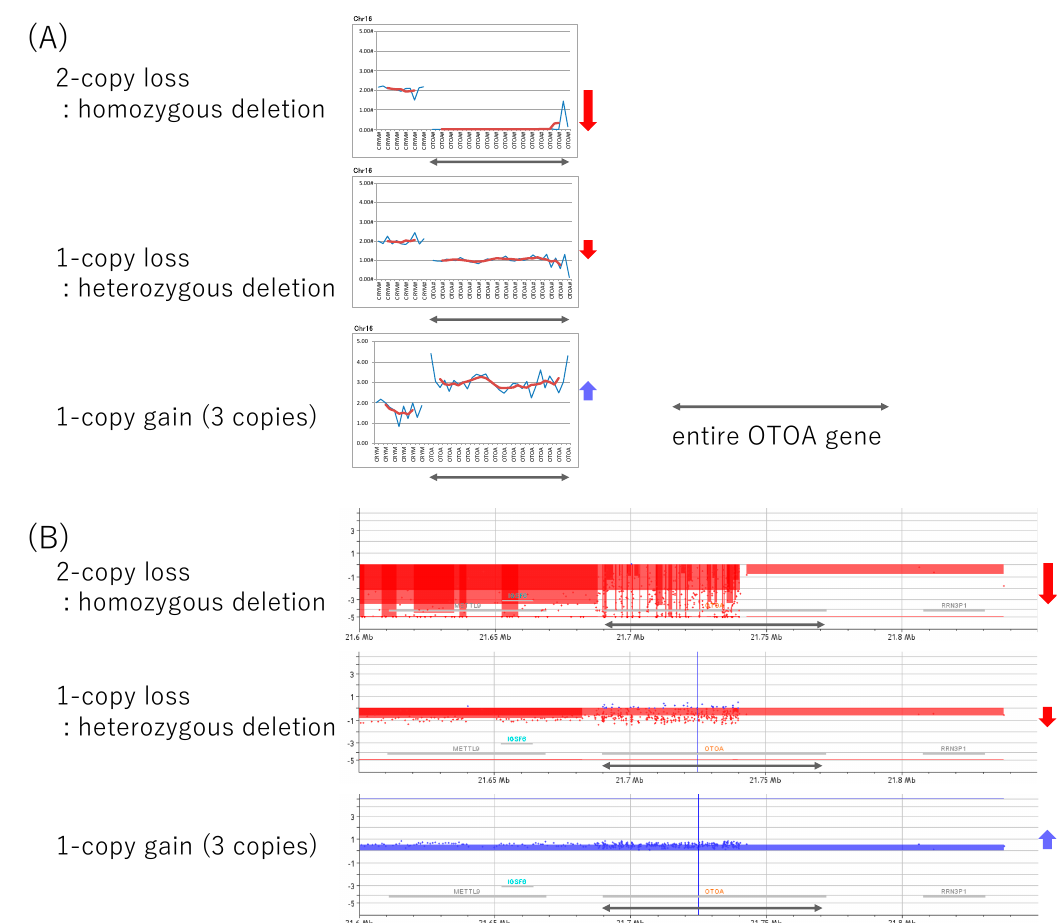
Figure 2. The results of copy number variation (CNV) analysis. ( A ) The results of CNV analysis based on next-generation sequencing (NGS) read depth data for patients with two-copy loss (homozygous deletion), one-copy loss (heterozygous deletion), or one-copy gain (three copies) in the OTOA gene identified in the present study. ( B ) The results of aCGH analysis for the same patients. Black arrows indicate the OTOA region. Red arrows indicate deletions, and blue arrows indicate duplications.